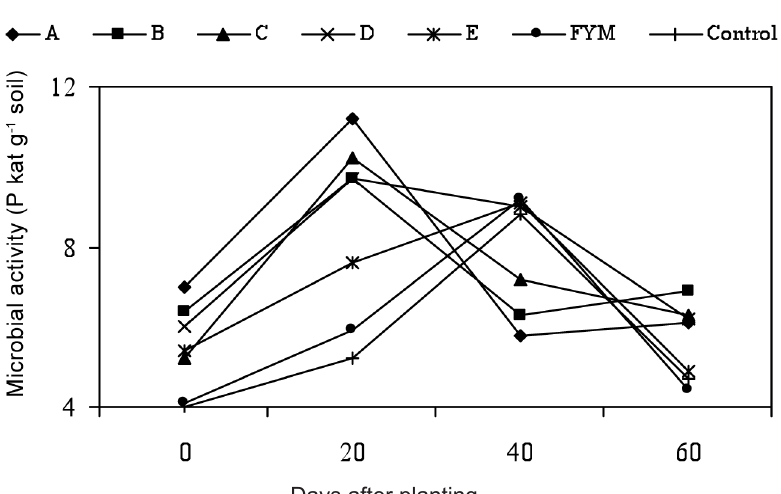
Figure 2. Microbial activity (dehydrogenase assay) at various sampling dates in field soil amended with composts and planted with cowpea in 2001. [A, Calotropis procera ; B, Prosopis juliflora ; C, weeds; D, Azadirachta indica and E, Acacia nilotica ]. LSD ( P =0.05) of treatment (0.37) and interval